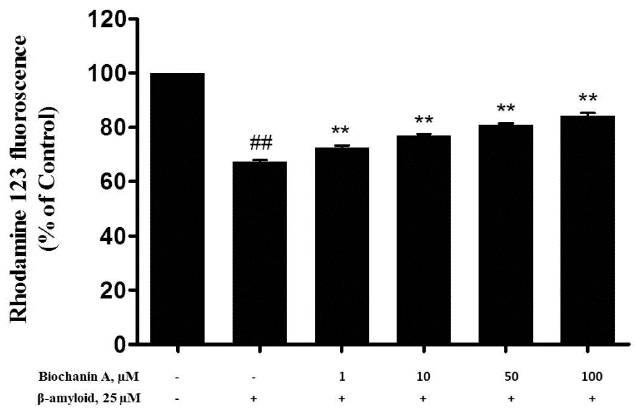
Figure 5. Effect of biochanin A on the mitochondrial membrane potential in A β 25–35 -treated PC12 cells. The cells were pretreated with biochanin A (1, 10, 50, and 100 μ M) for 2 h before exposure to 25 μ M A β 25–35 for another 24 h. Values given are the mean ± S.E.M. of four independent experiments. ** p < 0.01 compared with the group treated with A β 25–35 alone; ## p < 0.01 compared with the control group. “ − ”and “+”in the figure indicate “in the absent of” and “in the present of” respectively.